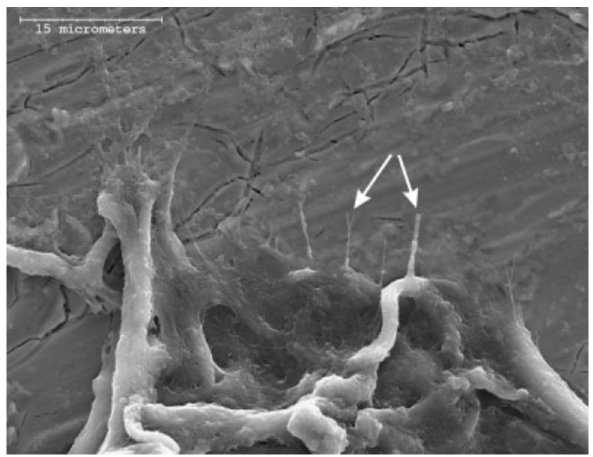
Figure 9. Adapted with permission from S. Areva et al. [50]. Copyright 2004 Elsevier. License num- ber 5318860867897 . Collagen fibers attach directly to a titania coating from mature fibroblasts.